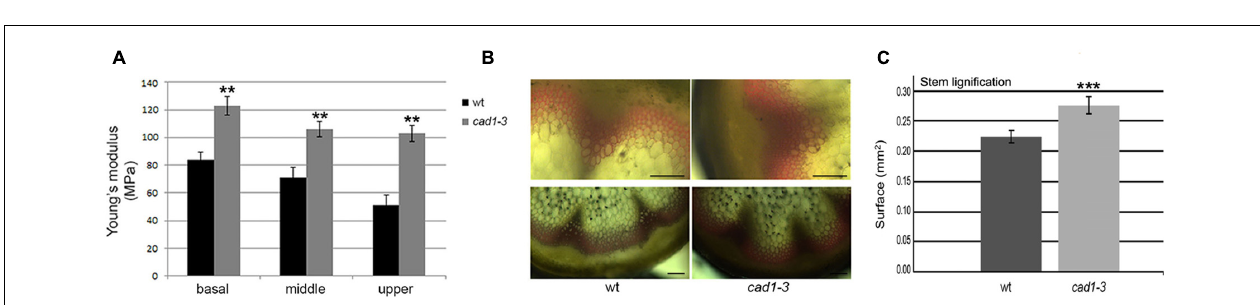
FIGURE 6 | Levels of sinapic acid hexoside in shoots (A) and ferulic acid derivative in roots (B) of wt and cad1-3 plants, grown under control conditions (cntr) or exposed to 36 µ M of CdCl 2 for 24 h. The metabolite relative content is reported as ion counts (arbitrary units, a.u.). n = 5, error bars indicate SE; statistics as in Figure 1 .